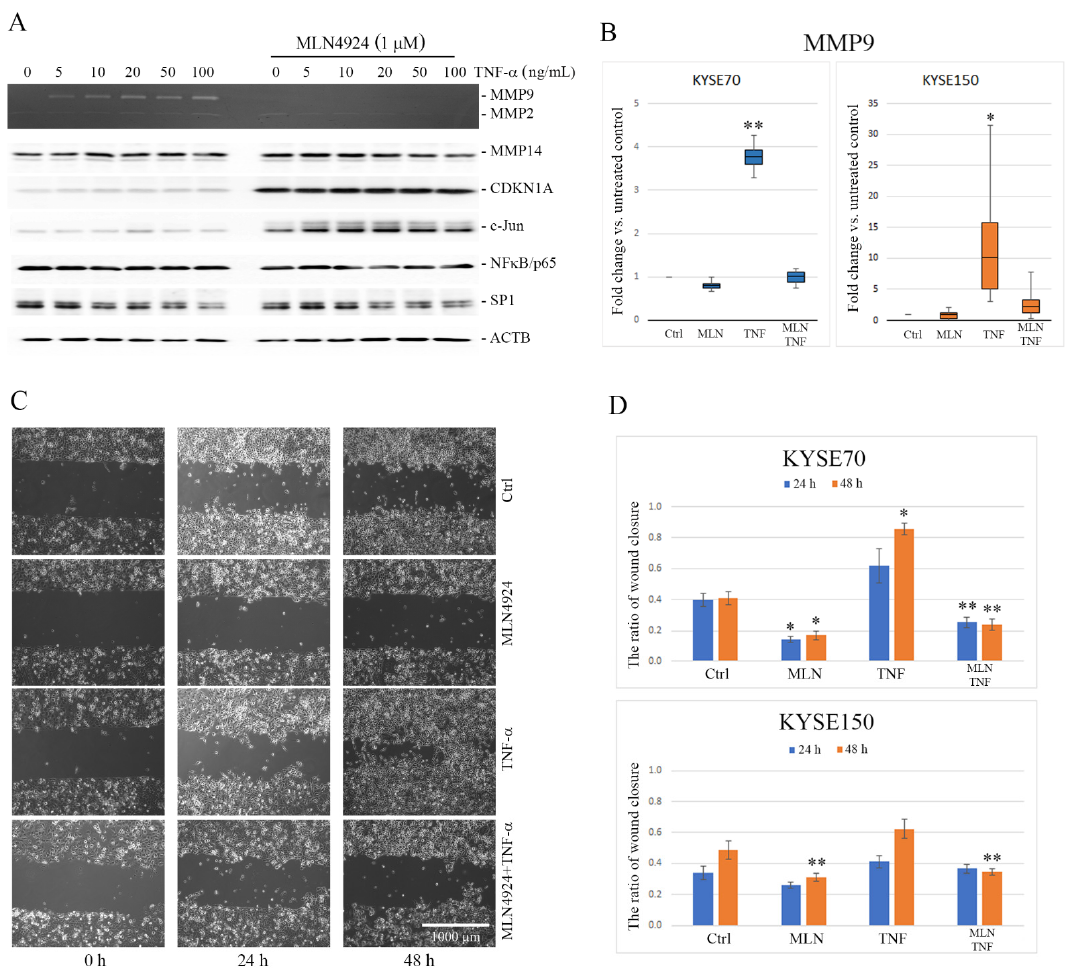
Figure 1. Effect of tumor necrosis factor-alpha (TNF- α ) and MLN4924 on matrix metalloproteinase 9 (MMP9) expression and esophageal squamous cell carcinoma (ESCC) cell migration. ( A ) After overnight serum starvation, KYSE150 cells were pretreated or not with 1 µM MLN4924 for 30 min and then stimulated with TNF- α at the indicated concentration for 24 h. Activity of MMP9 and MMP2 was analyzed by gelatin zymography in the conditioned media. The protein levels of membrane type I-matrix metalloproteinase (MT1-MMP), cyclin dependent kinase inhibitor 1A (CDKN1A/p21), c-Jun, nuclear factor kappa B (NF κ B) and SP1 were determined by Western blotting. Fold change calculated as the ratio of relative levels of proteins normalized to β -actin (ACTB) between the cells treated with TNF- α in combination with MLN4924 and the cells treated with TNF- α alone is shown in Figure S4. Values shown are means ± SEM: whiskers: min–max. ( B ) MMP9 messenger RNA (mRNA) expression was analyzed by reverse transcription quantitative real-time polymerase chain reaction (RT-qPCR) in both KYSE150 and KYSE70 cells treated for 24 h with TNF- α (30 ng/mL) and MLN4924 (1 µ M) alone or in combination. Results are presented as fold change of MMP9 gene in the treated cells relative to the untreated controls normalized to the expression of the reference gene encoding glyceraldehyde 3-phosphate dehydrogenase ( GAPDH ). ( C ) Representative images from wound healing assay showing the changes in KYSE70 cell migration under MLN4924 and TNF- α applied separately and in combination after 24 h and 48 h treatment in relation to the untreated controls. The cells were seeded in silicone inserts and allowed to attach and form a confluent monolayer. After the inserts were removed, the cells were treated with TNF- α (30 ng/mL) and MLN4924 (1 µ M) separately or in combination and incubated for the next 48 h. Images of cell-free artificial wounds were taken at 0, 24 and 48 h. ( D ) Quantitative analysis of wound closure. Summary bar graphs illustrating the ratio of wound closure after 24 and 48 h quantified for KYSE150 and KYSE70 cells. Values shown are means ± SEM. * p < 0.001, ** p < 0.05 vs. control. Ctrl—untreated